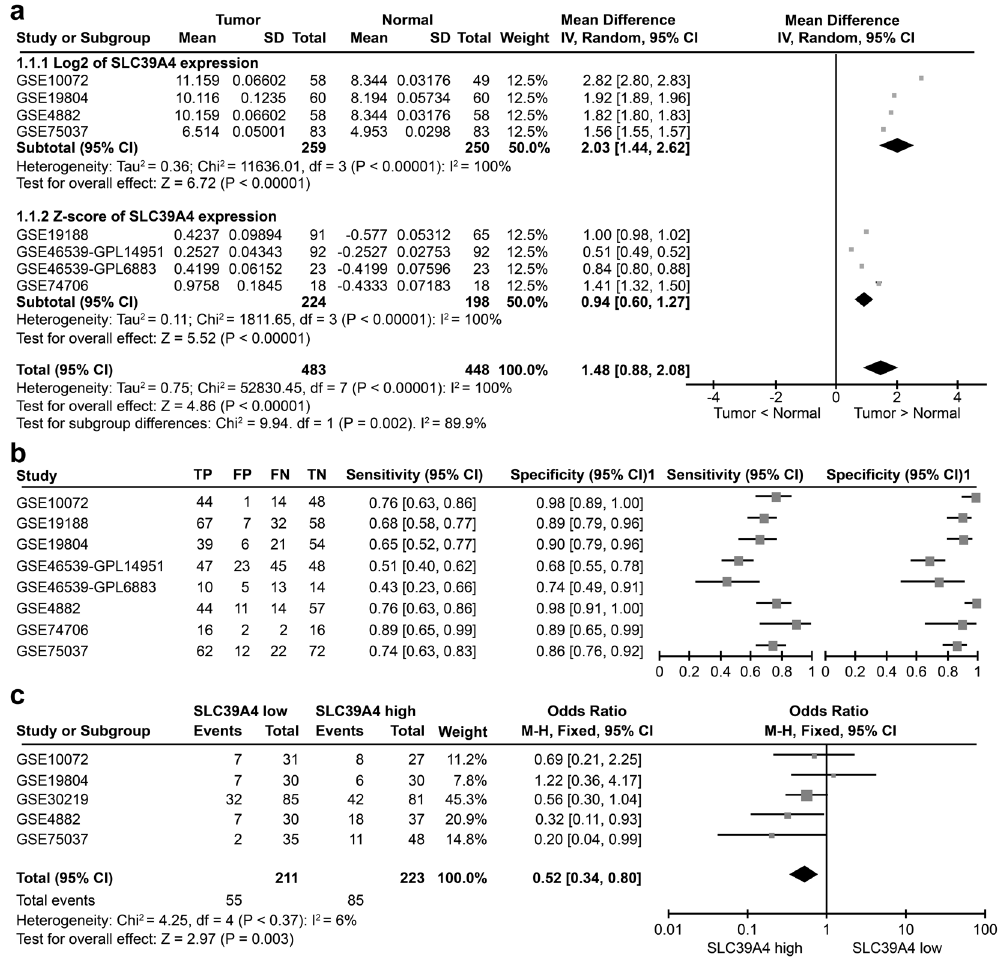
Figure 1. SLC39A4 is an independent predictor of non-small cell lung cancer (NSCLC). ( a ) Meta-analysis of SLC39A4 expression in NSCLC samples and normal tissues. Mean differences were estimated using an inverse variance (IV)-weighted random-effects model (Mean difference, 1.48; 95% CI, 0.88–2.08). ( b ) Meta-analysis of SLC39A4 specificity and sensitivity as a biomarker of NSCLC. ( c ) SLC39A4 expression association with tumour stage using a Mantel-Haenszel (M-H)-weighted random-effects model (Odds Ratio [OR], 0.52; 95% CI,